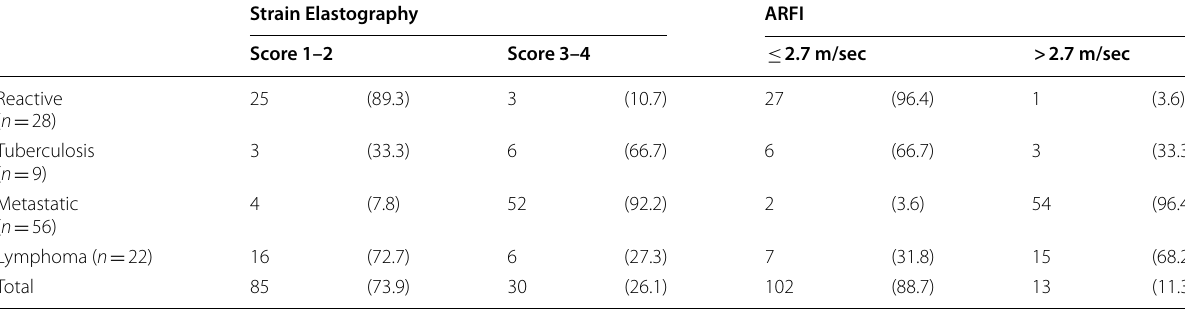
Table 3 Correlation of diagnosis obtained by SE and ARFI and the final histopathological